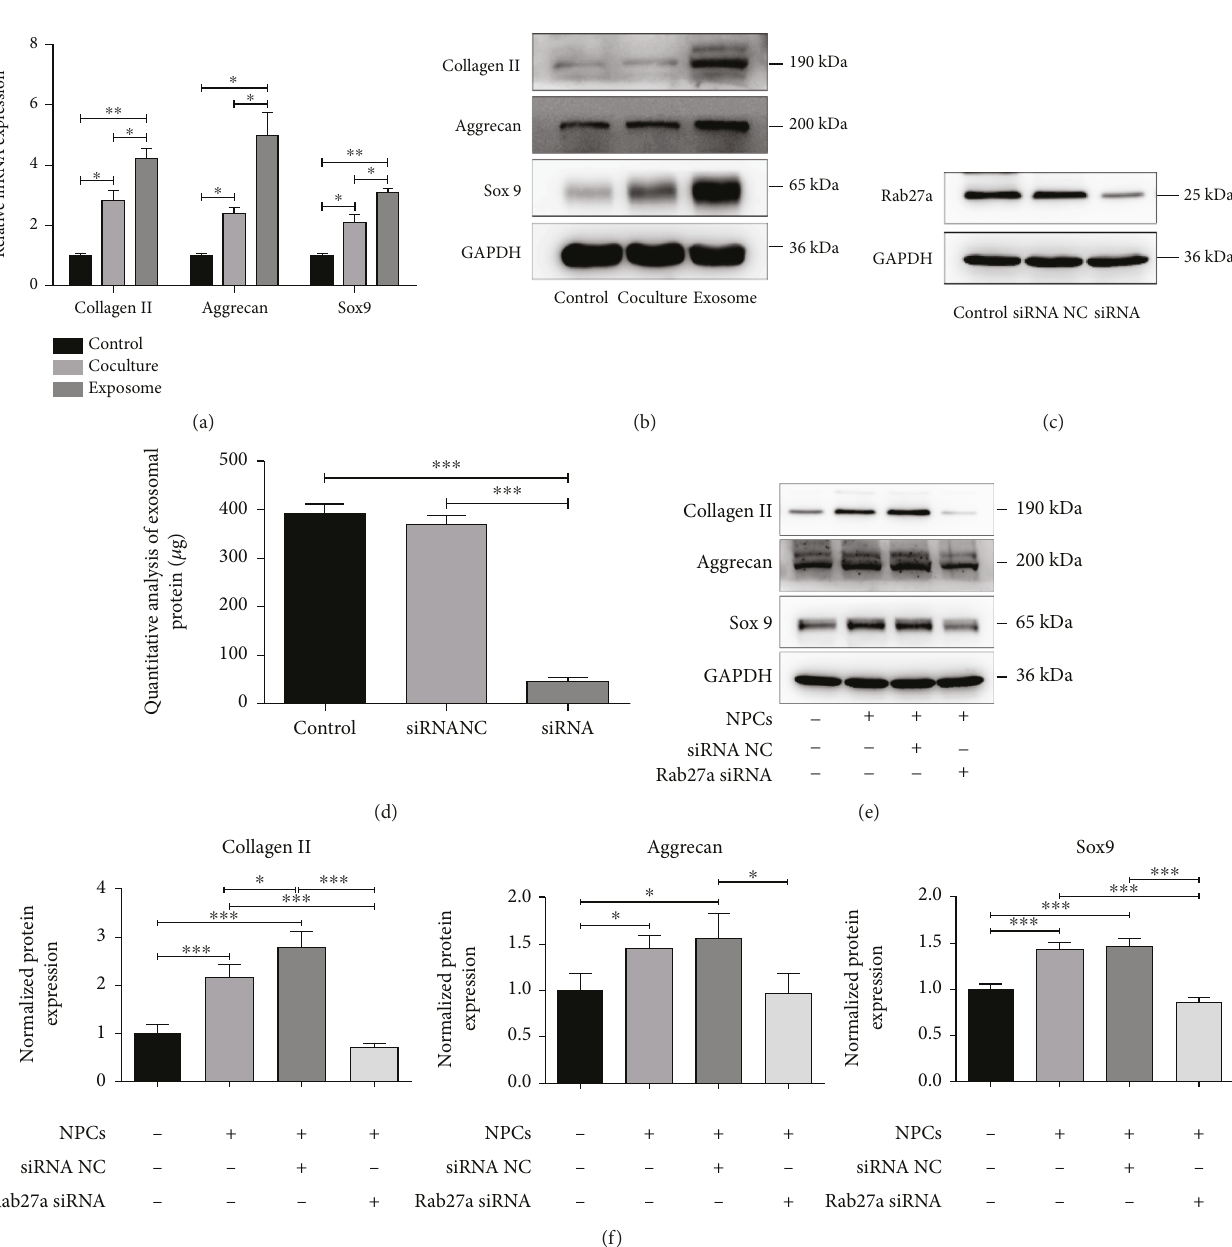
Figure 5: NPC exosomes played a key role in MSC di ff erentiation into NP-like cells in an indirect coculture system. (a, b) Expression of collagen II, aggrecan, and Sox9 in the coculture group was higher than that in the control, but lower than the coculture group ( P < 0 05 ). Control: MSCs cultured alone; coculture group: MSCs indirectly cocultured with NPCs; exosome group: MSCs treated with NPC exosomes (50 μ g/ml). (c) NPC Rab27a protein was knocked down via Rab27a siRNA transfection. (d) Exosomal proteins were extracted from the culture medium of the control group, siRNA NC group, and siRNA group and quanti fi ed with Bradford protein assay. Each group contain 1 × 10 6 cells. Control: NPCs cultured alone; siRNA NC group: NPCs transfected with Rab27a siRNA-negative control; siRNA group: NPCs transfected with Rab27a siRNA. (e, f) Expression of collagen II, aggrecan, and Sox9 was analyzed by western blot analysis in MSCs, which were cocultured with NPCs transfected with Rab27a siRNA-negative control and Rab27a siRNA-negative control and Rab27a siRNA. All data were showed as mean ± SD . N = 3 . ∗ P < 0 05 , ∗∗ P < 0 01 , and ∗∗∗ P < 0 001